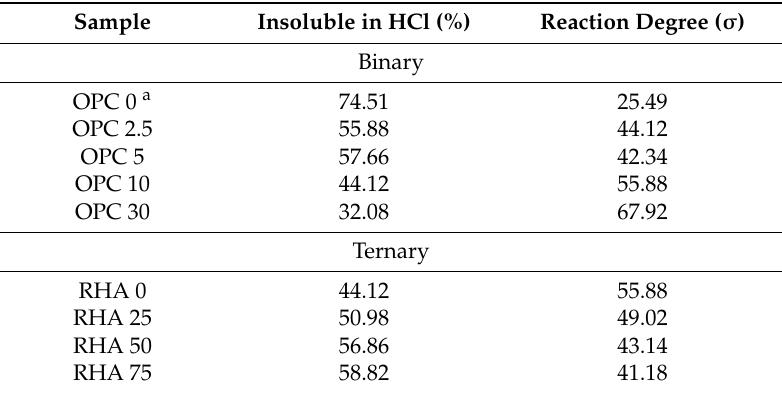
Table 5. Reaction degree after paste HCl attack